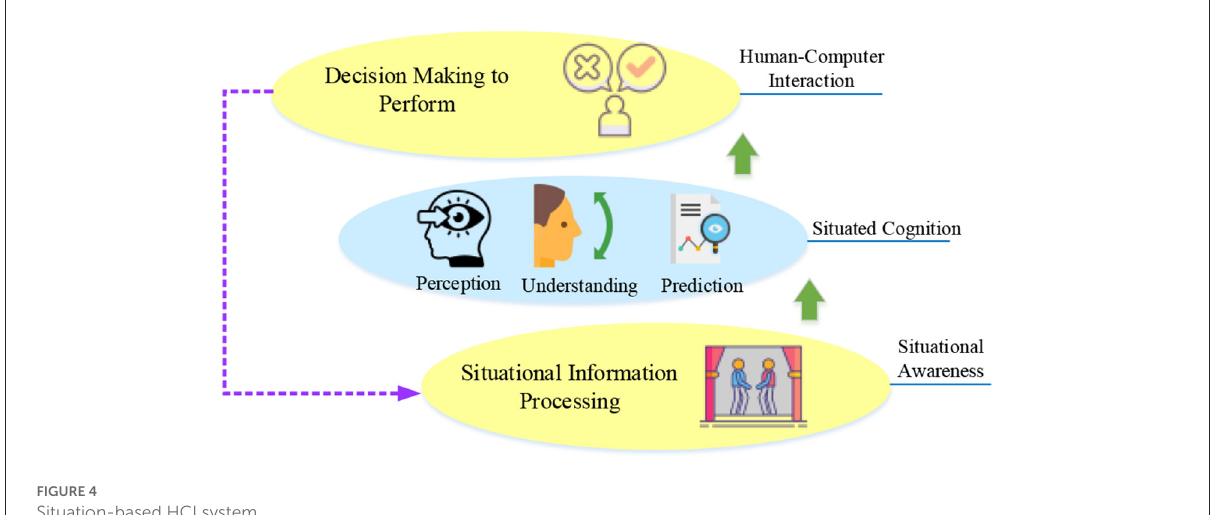
FIGURE4 Situation-based HCI system.